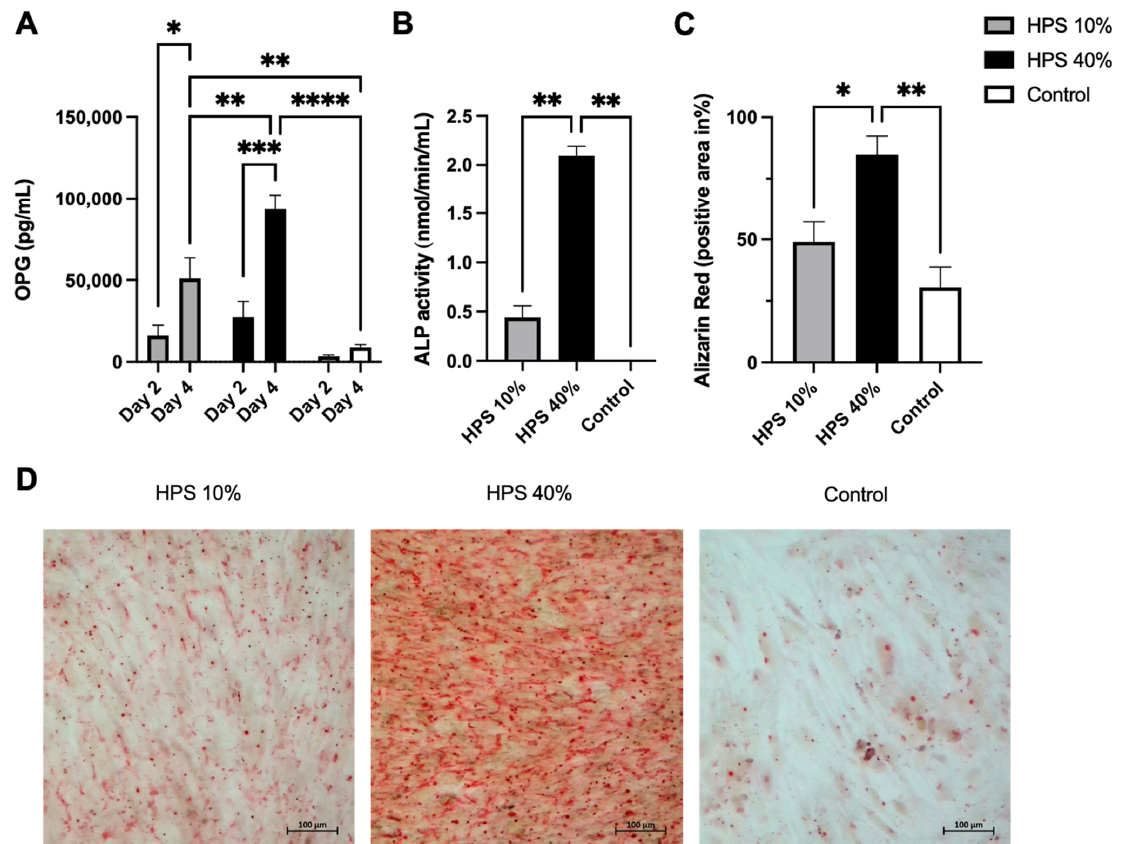
Figure 3. Hypoxia preconditioned serum (HPS) enhances osteogenic effects by upregulation of OPG secretion and ossification in human osteoblasts. ( A ) Quantitative measurement of Osteoprotegerin (OPG) levels in culture supernatants after 2 and 4 days of HPS-10%/-40% stimulation of human osteoblasts compared to controls. Time- and dose-dependent upregulation of OPG secretion was observed with HPS stimulation. Two-way repeated-measures ANOVA with Tukey’s multiple com- parisons test. Data points are means ± SEM, n = 3. * p < 0.05, ** p < 0.01, *** p < 0.001, **** p < 0.0001. ( B ) Alkaline phosphatase (ALP) activity. Following 4 days of HPS stimulation, human osteoblasts were analyzed for ALP activity, which was higher with the higher dose of HPS-40% stimulation compared to HPS-10% and controls. ( C ) Quantitative Alizarin red measurement by digital photo- graph analysis. Calcification was elevated with higher HPS concentration (HPS-40%) compared to HPS-10% and controls. ( B ) + ( C ): One-way ANOVA with Tukey’s multiple comparisons test. Data points are means ± SEM, n = 3. * p < 0.05, ** p < 0.01. ( D ) Representative high-power fields of Alizarin red staining of HPS-10%, HPS-40% stimulated osteoblasts and controls. Scale bar = 100 µm.